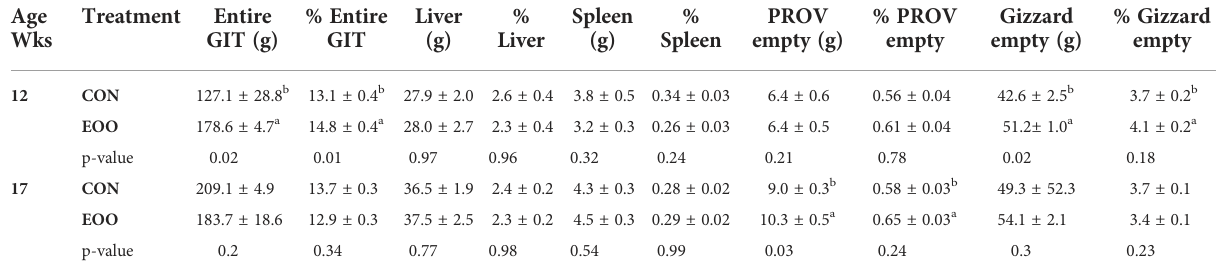
TABLE 4 Gastrointestinal traits of pullets ’ organ weights at 12 and 17 weeks of age. Age Treatment Entire Wks GIT